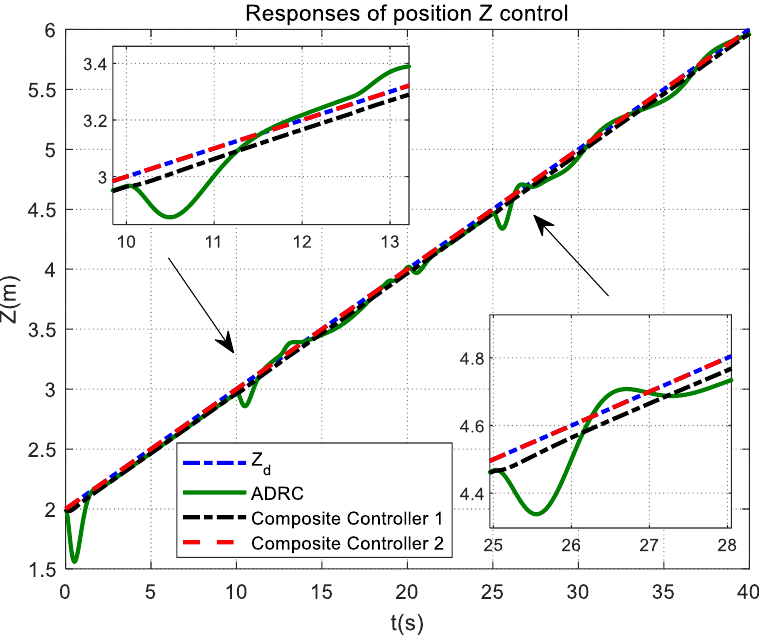
Figure 19. Responses of position Z control for QUAV under actuator time‑varying fault and disturbance condition.